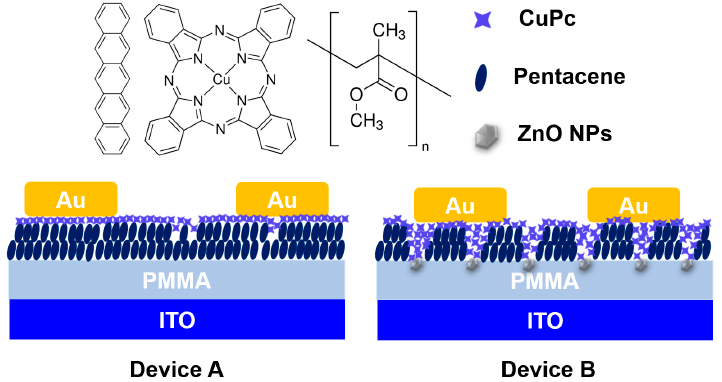
Figure 1. Molecular structures of the pentacene, CuPc and PMMA, along with the organic field-effect transistor (OFET)-based sensor device configurations in this study, device A with only CuPc/Pentacene heterojunction; device B with both ZnO/PMMA hybrid dielectric and CuPc/Pentacene heterojunction.